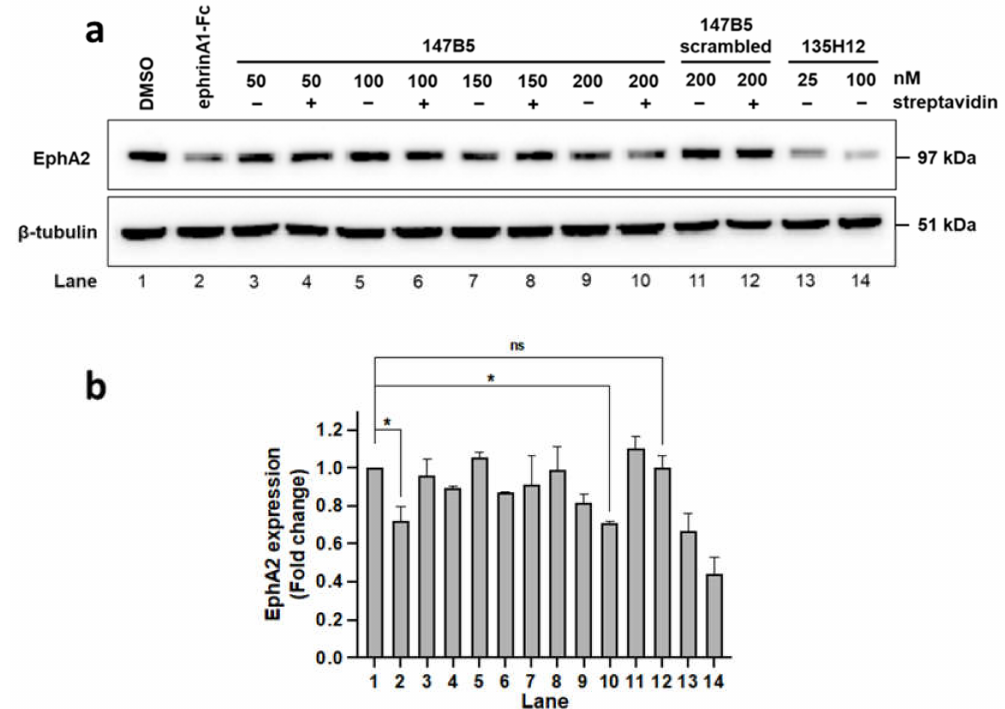
Figure 4. Effect of 147B5 and its complexes with streptavidin at various ratios on EphA2 receptor degradation. ( a ) Western blot study of BxPC3 pancreatic cancer cells treated (1 h) with ephrinA1-Fc, EphA2 agents 135H12 (135H11 synthetic dimer; tested at 50 nM and 200 nM monomer concentration), and 147B5 (50 nM to 200 nM) and its scrambled version (200 nM) (Table 1), tested in the absence and presence of streptavidin (50 nM), as indicated and for 1 h. Anti-EphA2 blot indicates that the positive-control ephrinA1-Fc (22 nM monomer) treatment led to nearly complete degradation of the EphA2 receptor, similar to (147B5) n -streptavidin when n = 2, 3 or 4 (hence at 100 nM, 150 nM, or 200 nM 147B5 concentration in the presence of 50 nM streptavidin), but not when n = 1. ( b ) Densitometry analysis based on duplicate measurements of band intensities relative to the bands of DMSO-treated cells. * p ≤ 0.05, as determined by a one-way analysis of variance using Dunnett post-test analysis. Uncropped images for the WB are available as supplementary